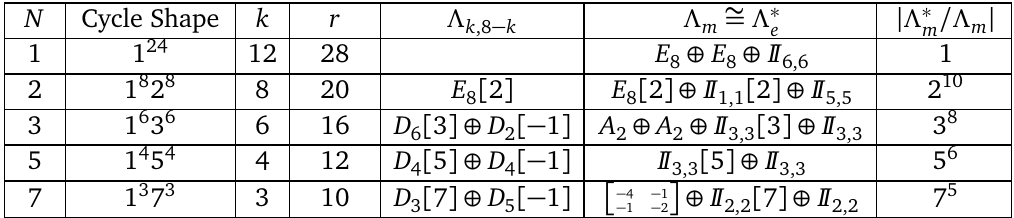
CHL orbifolds. Here k = 24 / ( N + 1 ) is the weight of the cusp form whose N is the lattice m / Λ is isomorphic to Z k + 2 . m N m listed here and Λ defined in (2.2) follows from the lattice m r − 6,6